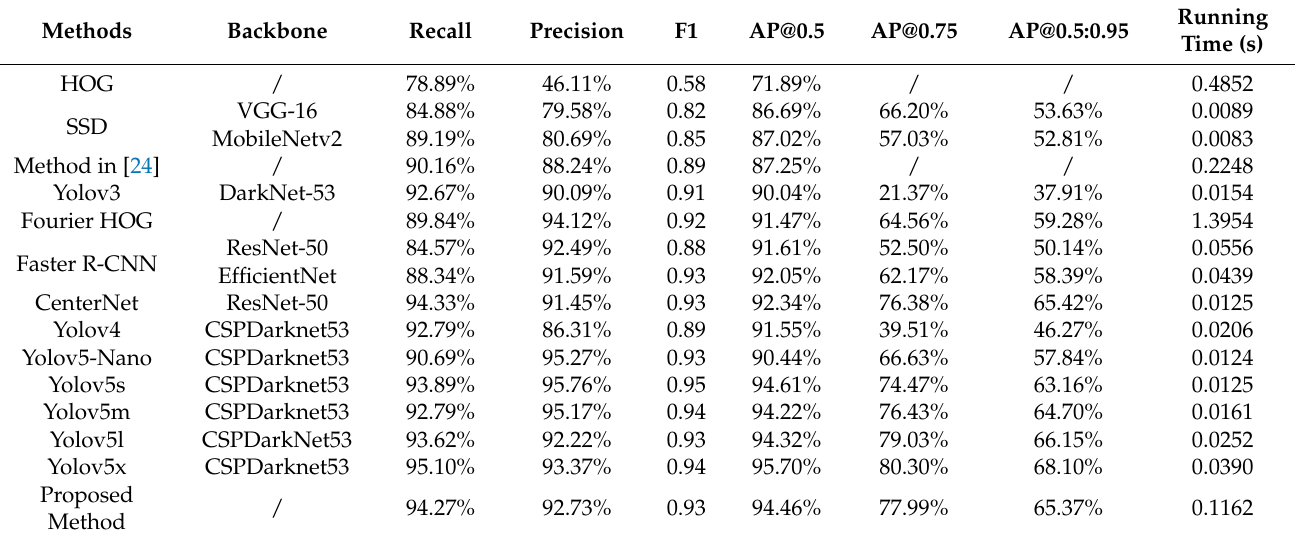
Table 2. The performance comparison of different methods on VRS ship